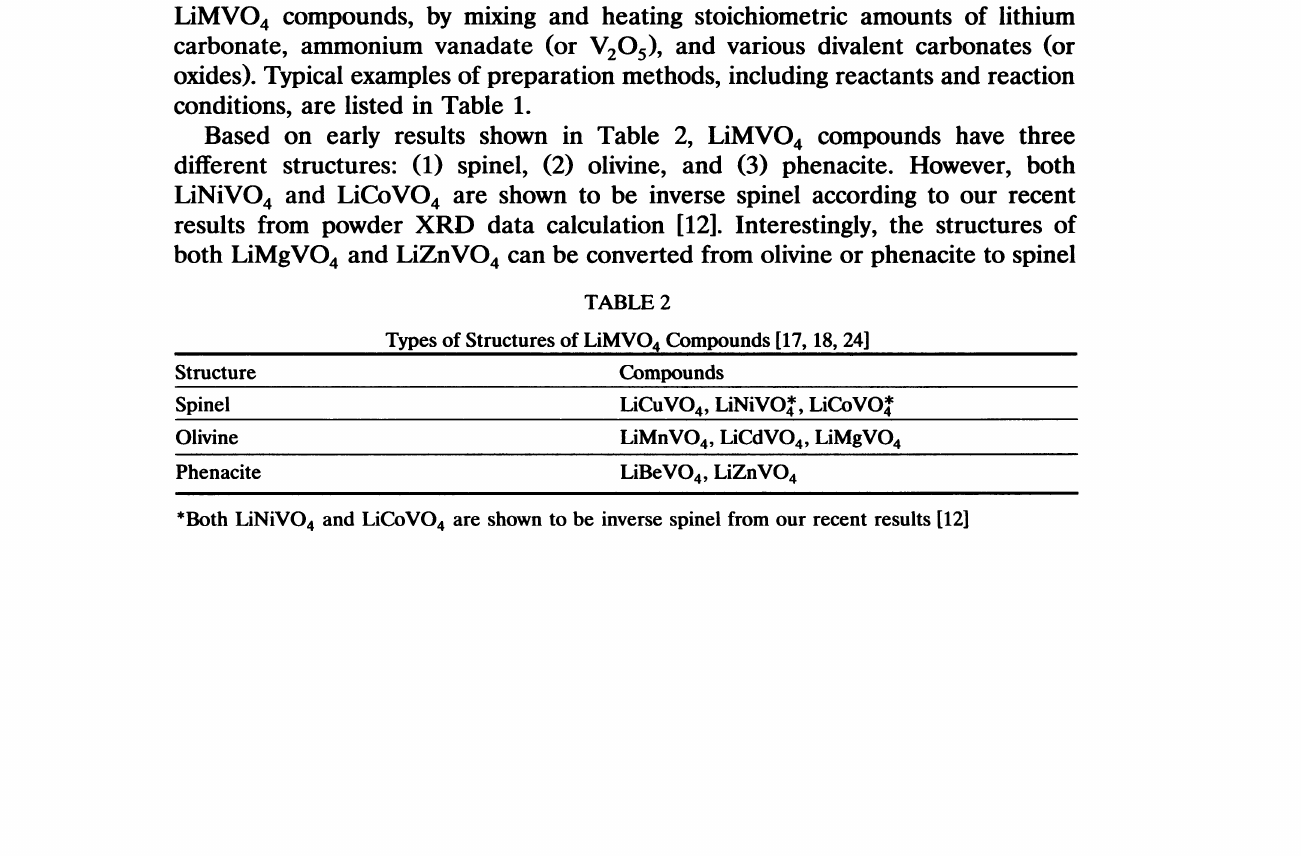
Compounds [17, 18, 24] 4